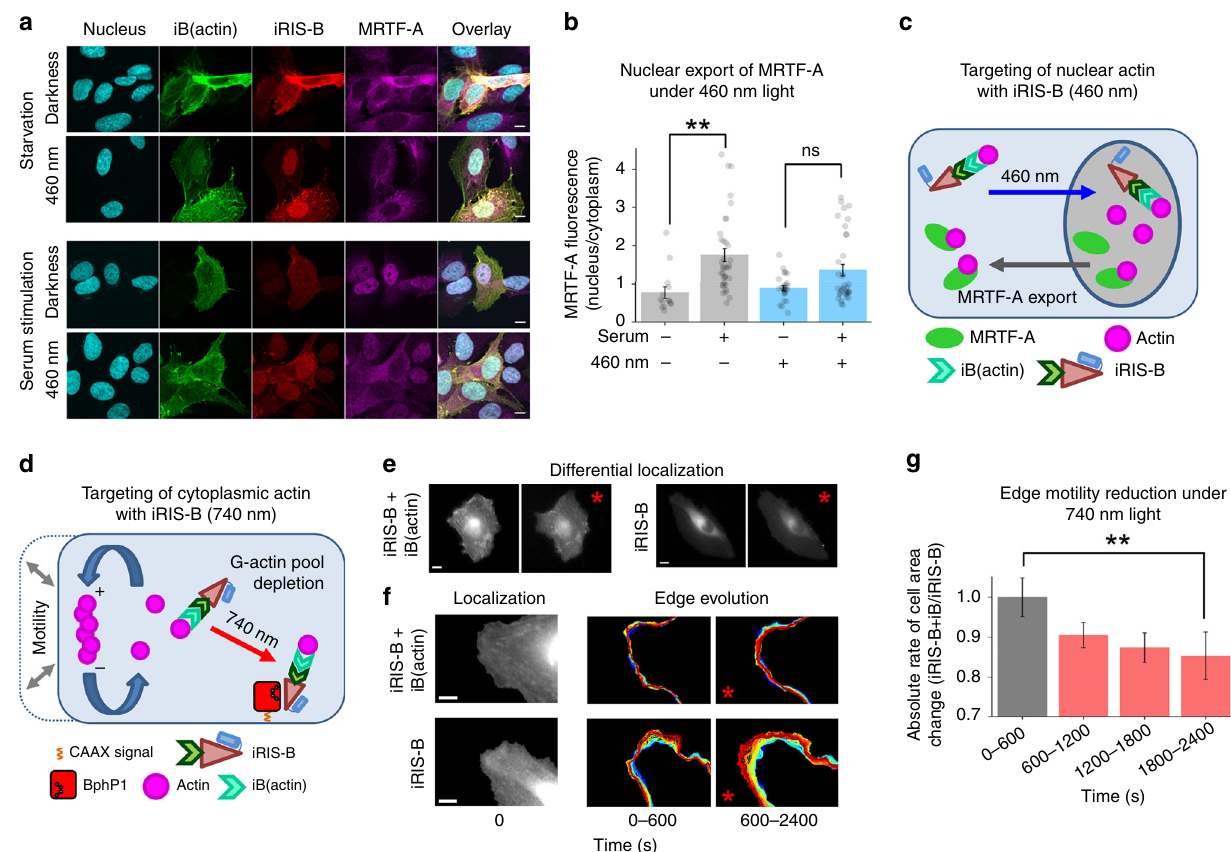
Fig. 5 Light-controlled regulation of cell motility and nuclear actin functions. a Light-dependent nuclear export of MRTF-A in cells co-expressing iRIS-B and iB(actin). After cell fi xation, MRTF-A was visualized using immunostaining. Confocal microscopy; scale bar, 10 µ m. b MRTF-A localization in cells expressing iB(actin) – iRIS-B system, error bars represent SEM, n = 14 – 35 imaged cells. ** p < 0.01, ns nonsigni fi cant at p = 0.01 (two tailed, Student ’ s t test). Source data are provided as a Source Data fi le. c Schematic representation of light-regulation of non-tagged nuclear actin by iB(actin) – iRIS-B system. d Schematic representation of light-control of cytoplasmic actin by iB(actin) – iRIS-B system. e NIR light-triggered perturbation of endogenous cytoplasmic actin by iRIS-B and iB(actin). 740 nm illumination is indicated by red asterisk. Epi fl uorescence microscopy; scale bars, 20 µ m. f Zoom-in views of the live- cell imaging of NIR light-triggered perturbation of endogenous cytoplasmic actin, as in e . Red asterisk indicates illumination by 740 nm light. Epi fl uorescence microscopy; scale bars 10 µ m. g Absolute values of the rate of cell area change during time-lapse experiments. Optogenetic sequestration of endogenous actin to the plasma membrane signi fi cantly impacted cell edge motion dynamics as a function of time. Data are shown as the ratio of average results from the condition in which both iB(actin) and iRIS-B were co-expressed, from the negative control condition in which only the iRIS-B was expressed. Light-activation started at 600 s time point and remained for the entire duration of assays thereafter. Representative examples of edge tracking traces are shown in Supplementary Fig. 8. n = 29 – 35 protrusion/retractions pooled from 3 – 4 independent experiments, shown with SEM, ** p < 0.01 (two tailed, Student ’ s t test). Source data are provided as a Source Data fi